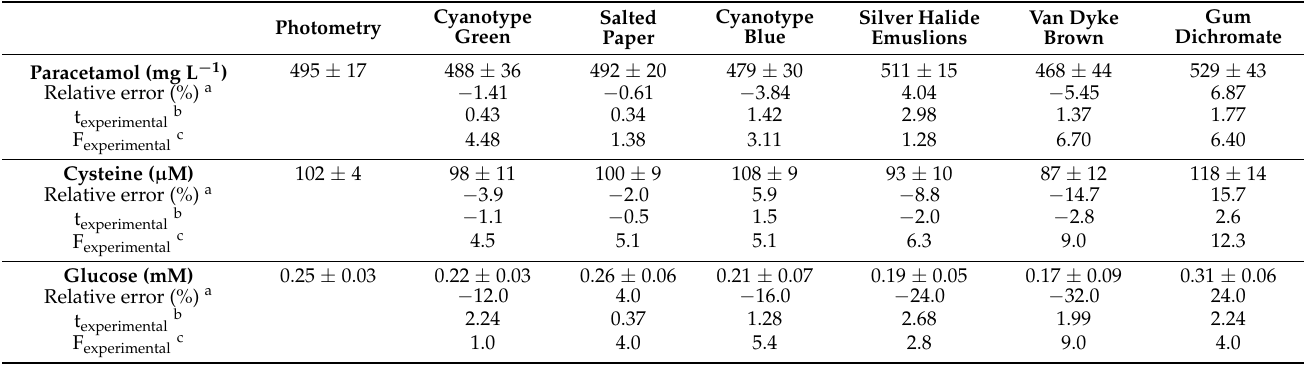
Table 3. Results from the analysis of real samples with various photosensitive paper coatings and comparison with standard